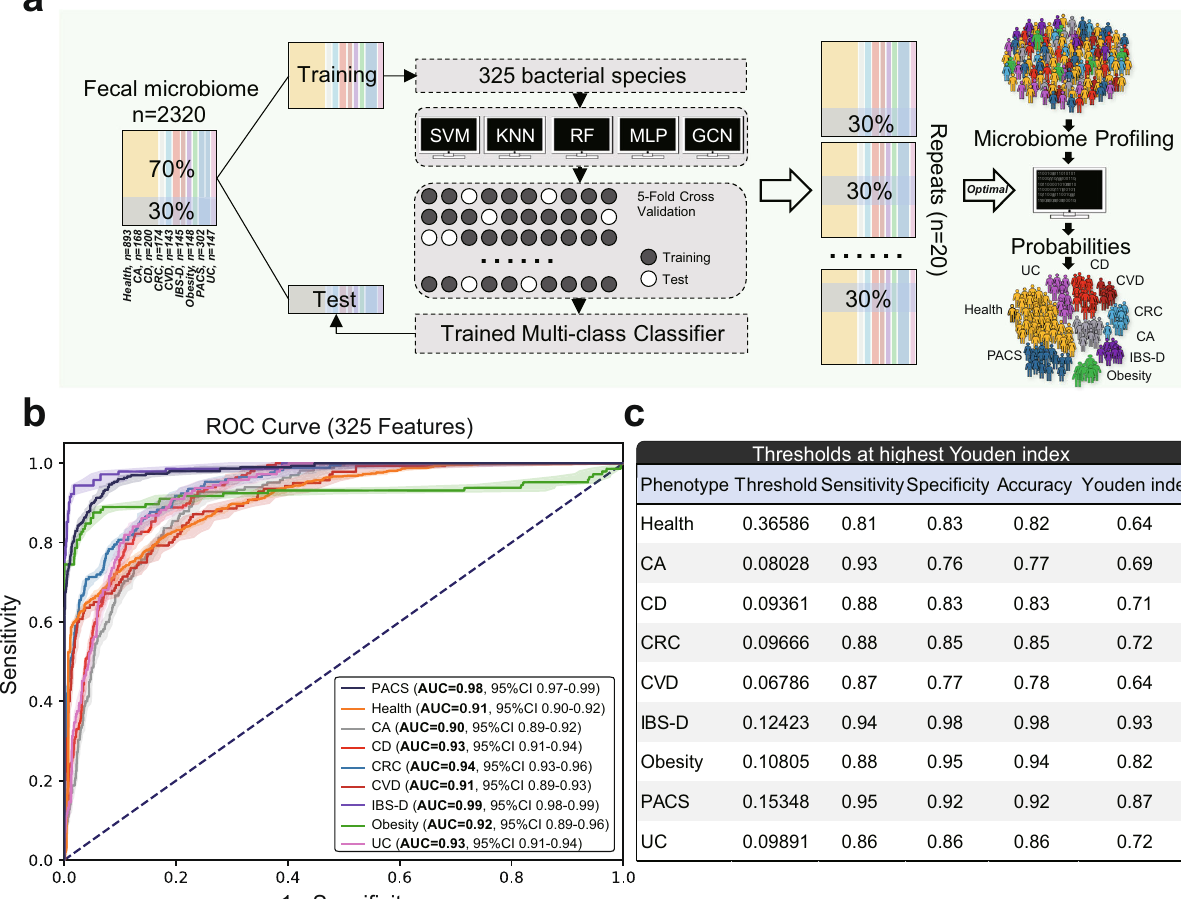
Fig. 1 | Faecal microbiome-based machine learning for multi-class disease diagnosis. a Framework for dataset partition, model training and independent validation. b Areaunderthereceiveroperatingcharacteristiccurve(AUROC,centre forthe error bandsis median). c Performancemetric detailsof the trained random forest multi-class classi fi er for classifying one phenotype from all others using species-level faecal microbiome data in the independent test set. SVM